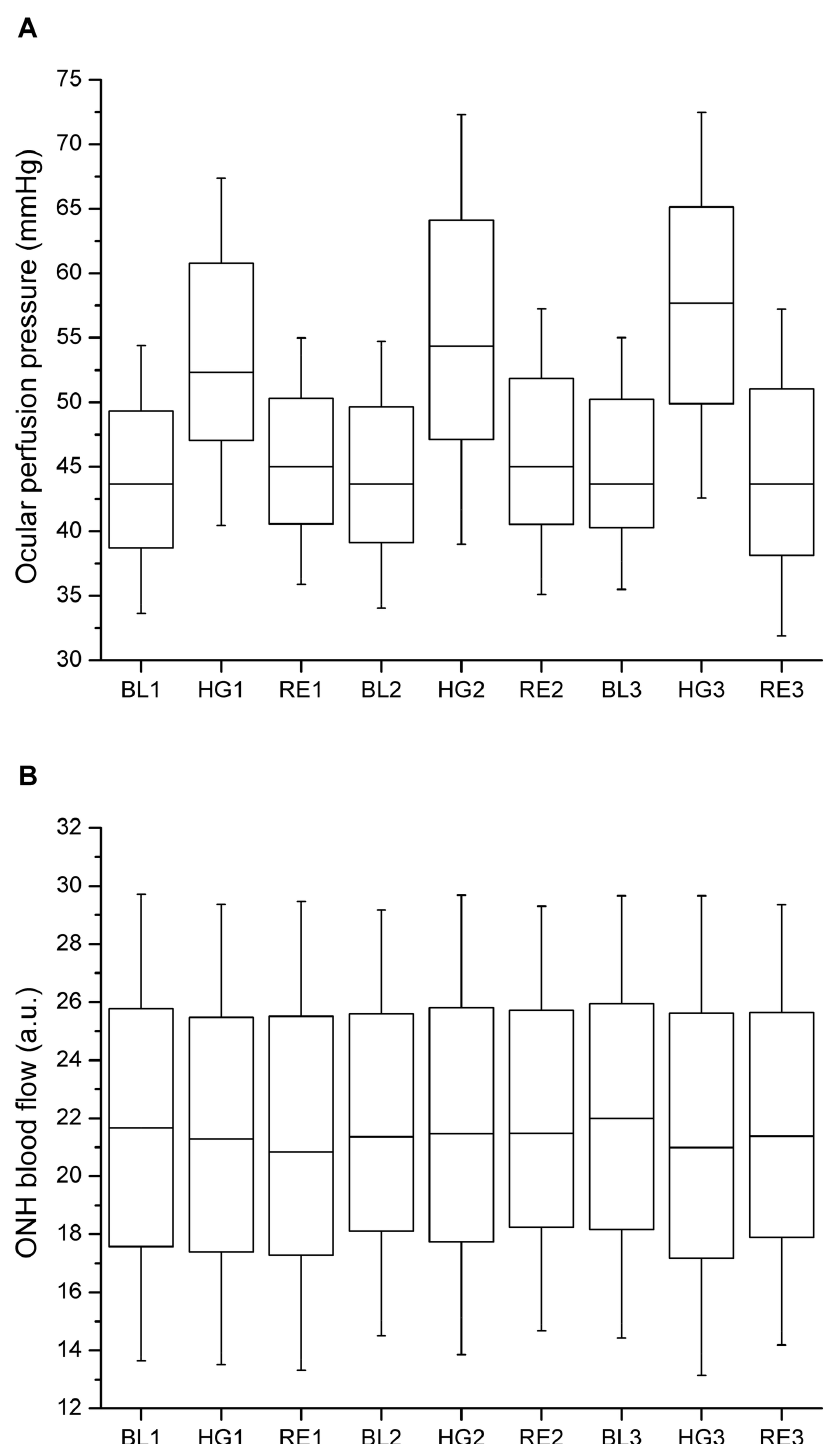
Figure 1. Effect of handgripping on ocular perfusion pressure (OPP, panel A) and optic nerve head blood flow (ONH blood flow, panel B). Three periods of isometric exercise were scheduled for each subject (n=39). Data are presented before during and after the 1 st handgripping experiment (BL1, HG1, RE1), before during and after the 2 nd handgripping experiment (BL2, HG2, RE2) and before during and after the 3 rd handgripping experiment (BL3, HG3, RE3). In the box-and-whisker blots the medians, standard deviations (SD) and 1.96 ± SDs are shown. doi: 10.1371/journal.pone.0082351.g001 PLOS ONE |